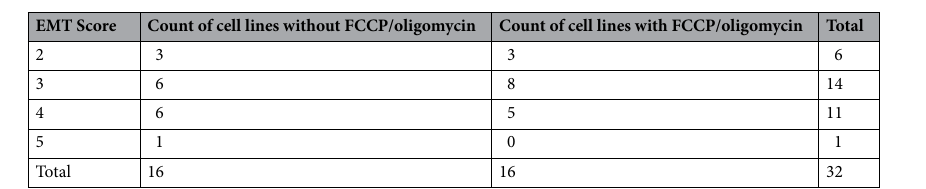
Table 1. Count of cell lines with EMT-scores in holotomographic microscopy of 4 HNSCC cell lines (range of possible scores from 0 to 9) with and without FCCP/oligomycin (p = 0.9).